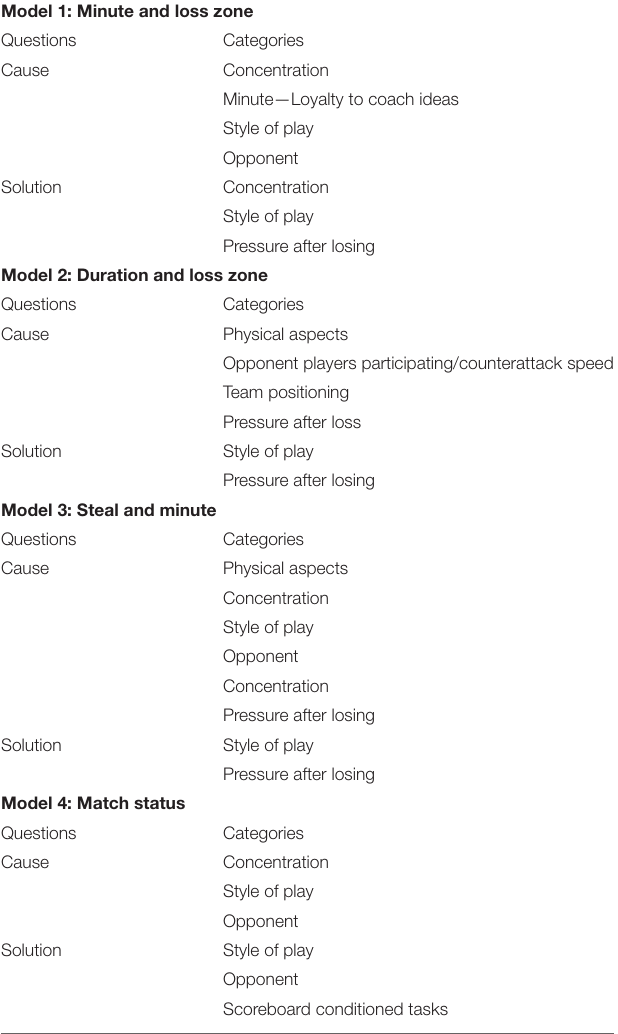
TABLE 2 | Questions and categories of the specific section of the interview based on the four predictive models of conceded goal-scoring opportunities. Model 1: Minute and loss